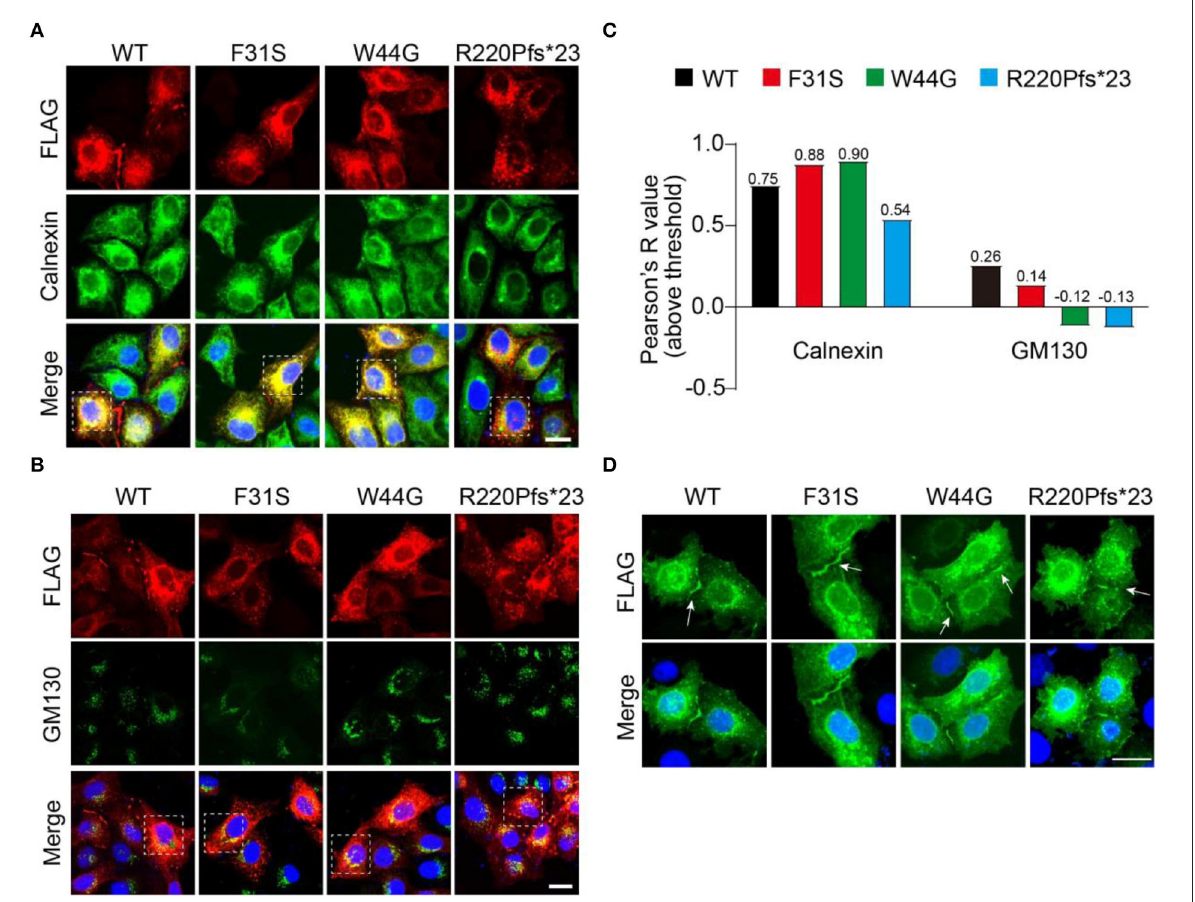
FIGURE5 Accumulation of GJB1 aggregates in endoplasmic reticulum. (A) Immunofluorescence staining of FLAG-tagged GJB1 variants and endoplasmic reticulum maker protein Calnexin in transfected HeLa cells. (B) Co-staining of GJB1-FLAG and Golgi maker protein GM130 in transfected HeLa cells. (C) Colocalization analysis of GJB1-FLAG with Calnexin or GM130 in highlighted cells in A and B. (D) Labeling GJB1-FLAG in the transfected cell shows clear GJ plaque structures in all groups. Blue indicates DAPI-labeled nuclei. Arrows indicate GJ plaques. Scale bar, 20 µ m.